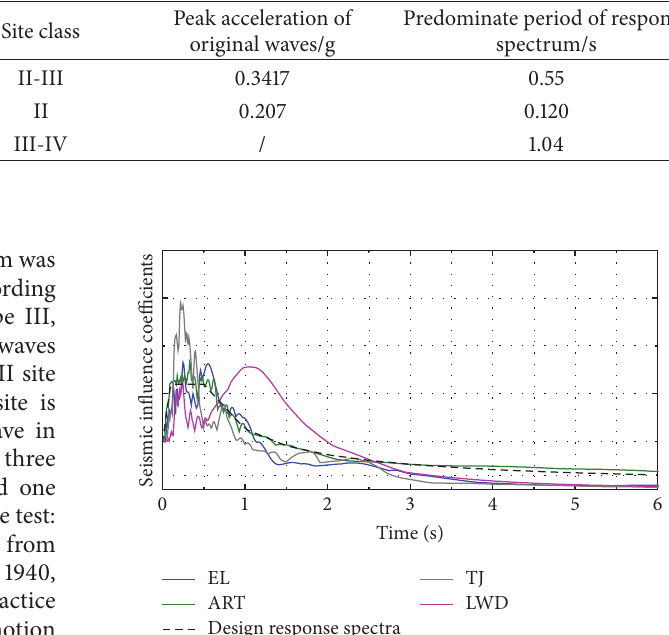
Figure 11: Acceleration response spectrums of four waves used in test and the design response spectra specified in the